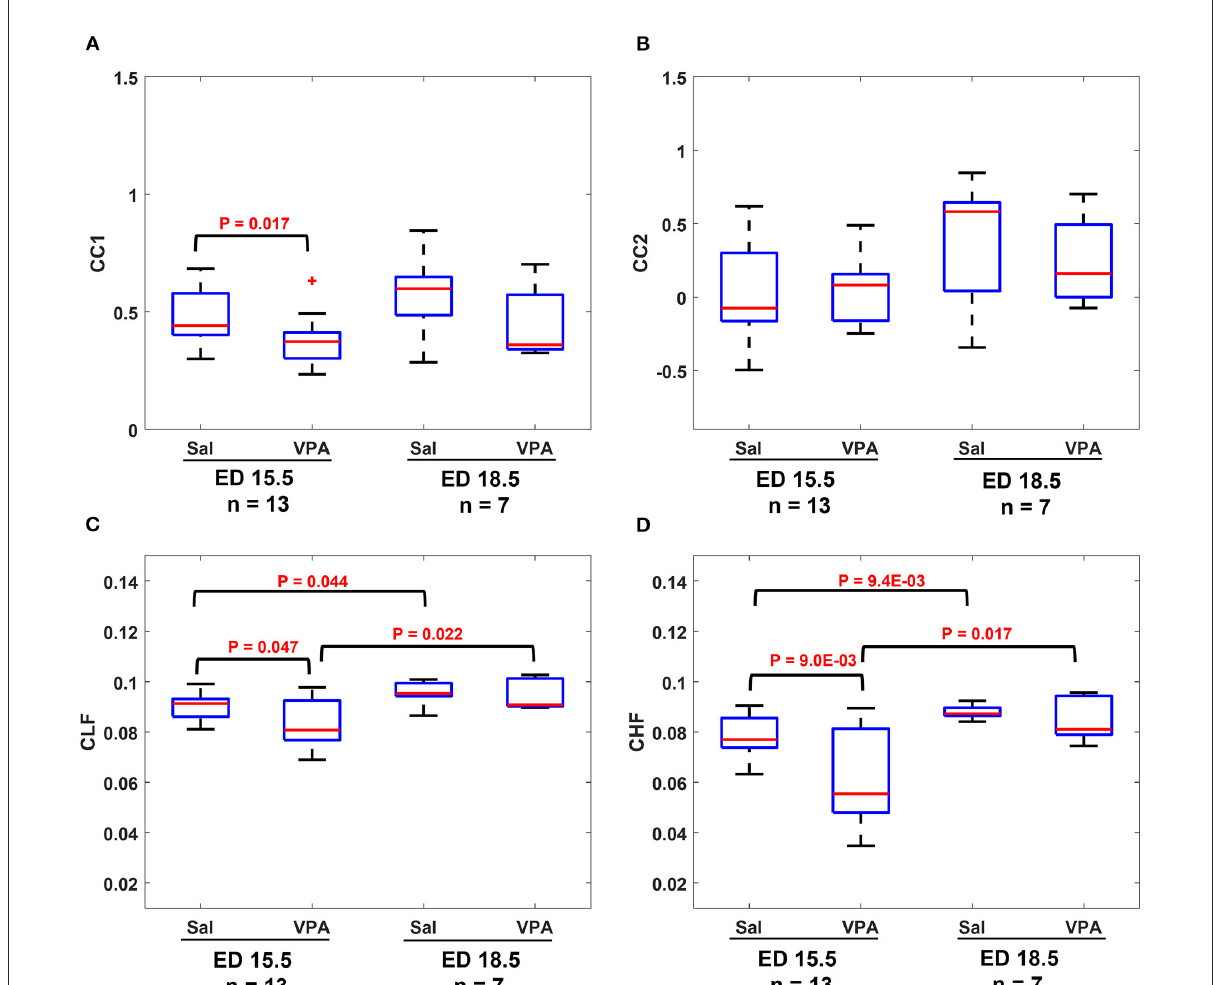
FIGURE5 Comparison between saline (sal) group and valproic acid (VPA) groups at embryonic day (ED) 15.5 and ED18.5. (A) CC1 coefficient. (B) CC2 coefficient. (C) Coherence low frequency (CLF) coefficient. (D) coherence high frequency (CHF) coefficient.